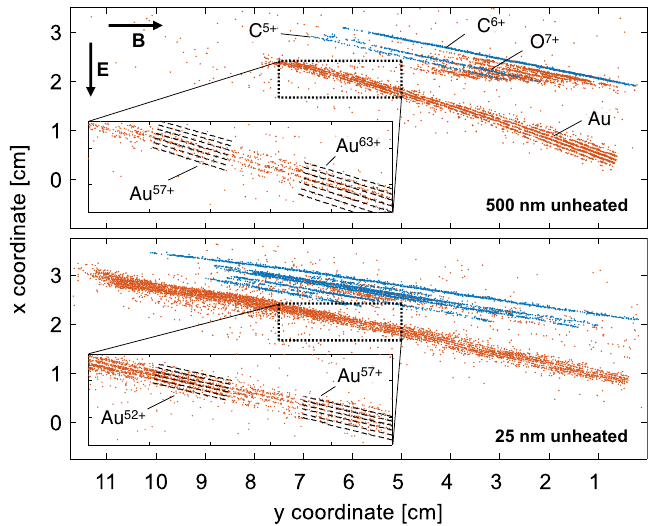
Figure 4. Raw data recorded with CR-39 for shots on unheated foils with a thickness of 500 nm (top), which delivered the best charge-state resolution and 25 nm (bottom), which resulted in the highest gold ion energies. The blue data points correspond to light ions, while the orange ones visualize larger pits caused by heavier ions, in particular gold. The grey dashed lines show the calculated lines for the mass-to-charge ratios of 2, 2.5 and 3, respectively. Details of the gold traces are shown in the insets. As indicated, the magnetic (electric) field deflected the ions to the right